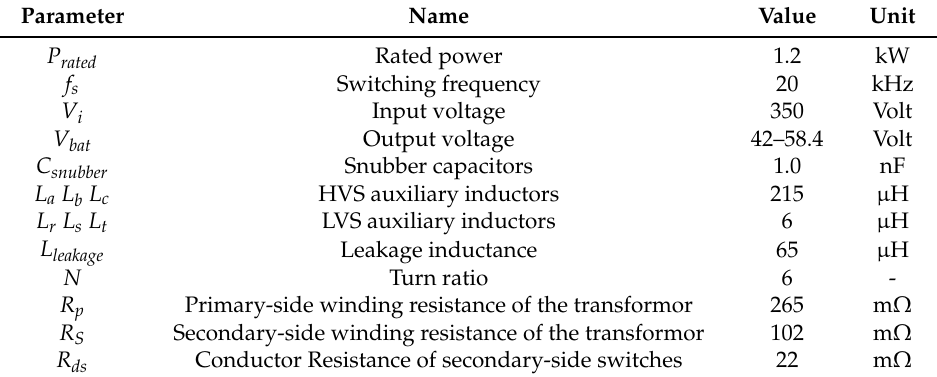
Table 1. Circuit parameters.